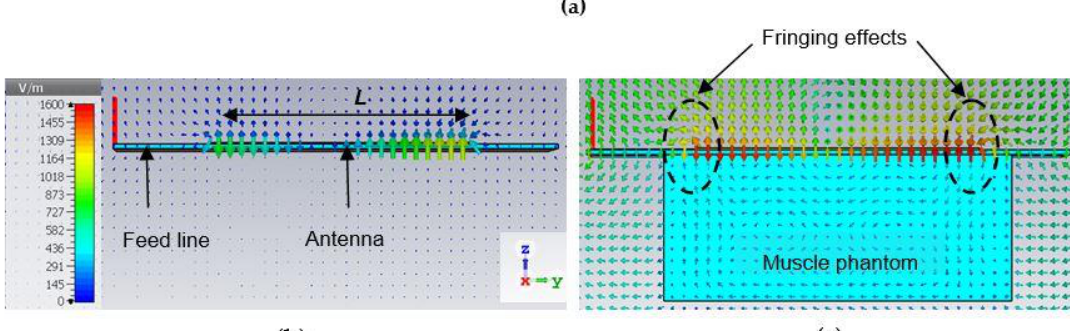
Figure 17. Efficiency and gain of e-textile antenna for various phantom properties. From an ideal antenna perspective, the efficiency is very low, which is due to the low conductivity and thickness of the developed material; however, through observation on the trend, it is clear that higher loss medium will result in lower gain. Table 3. Changes in the antenna’s performance variables when located on a human phantom in comparison to a free space condition. The significance of each parameter is explained in the paragraph.